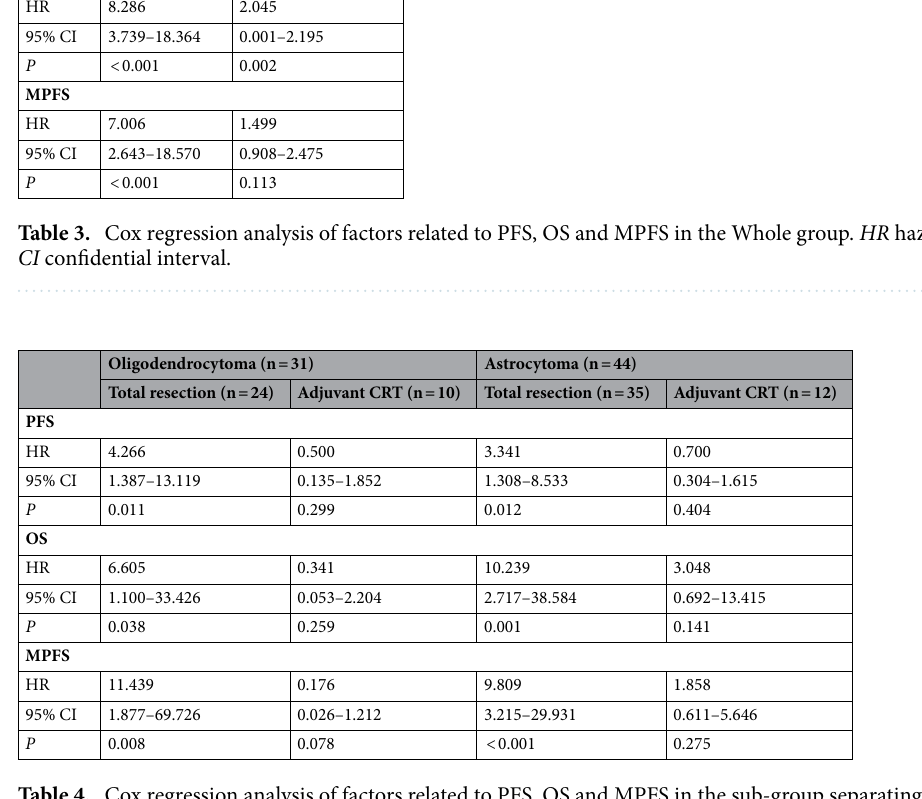
Table 4. Cox regression analysis of factors related to PFS, OS and MPFS in the sub-group separating oligodendrocytoma from astrocytoma. HR hazard ratio, CI confidential interval, CRT